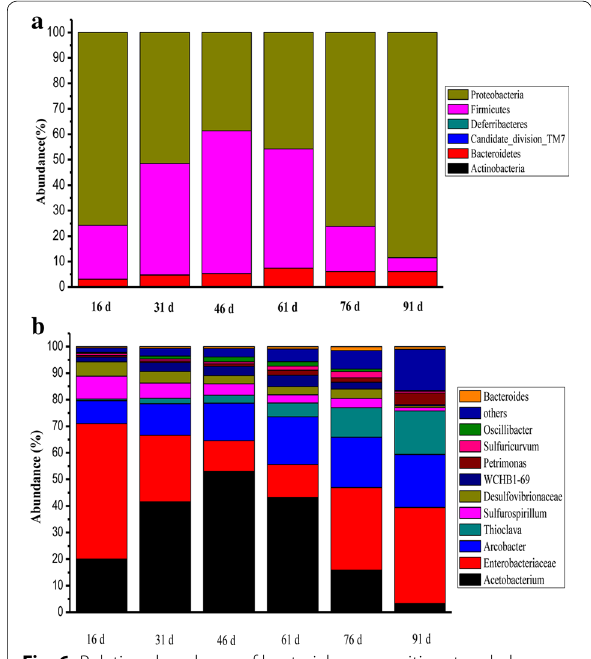
Fig. 6 Relative abundance of bacterial communities at a phylum and b genus levels in planktonic cells over time in the long‑term operation of MES for a DC power